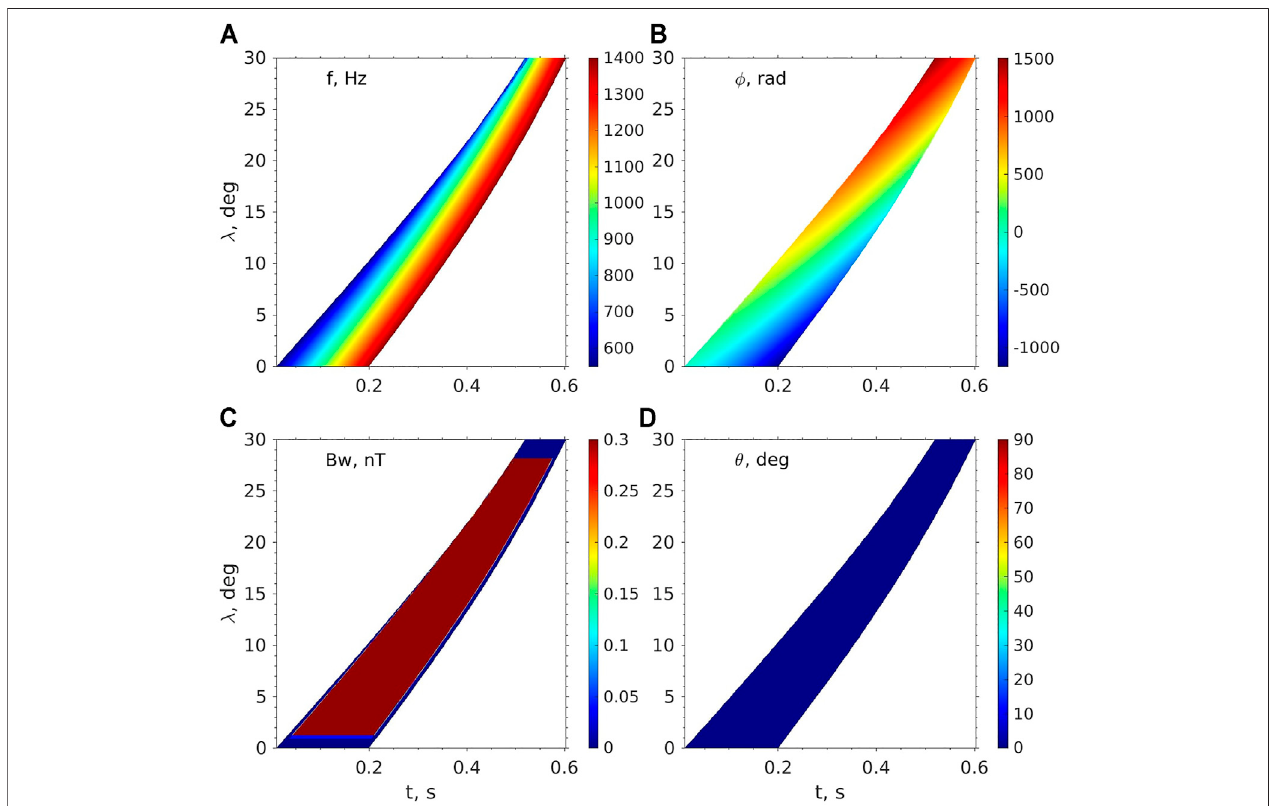
FIGURE2| Solutionofaducted choruselement along adipole magnetic fi eldat L (cid:1) 5.5. (A) wave frequency f (B) wavephase ϕ , (C) wavemagnetic amplitude B w , and (D) wave normal angle θ as a function of time t and magnetic latitude λ .